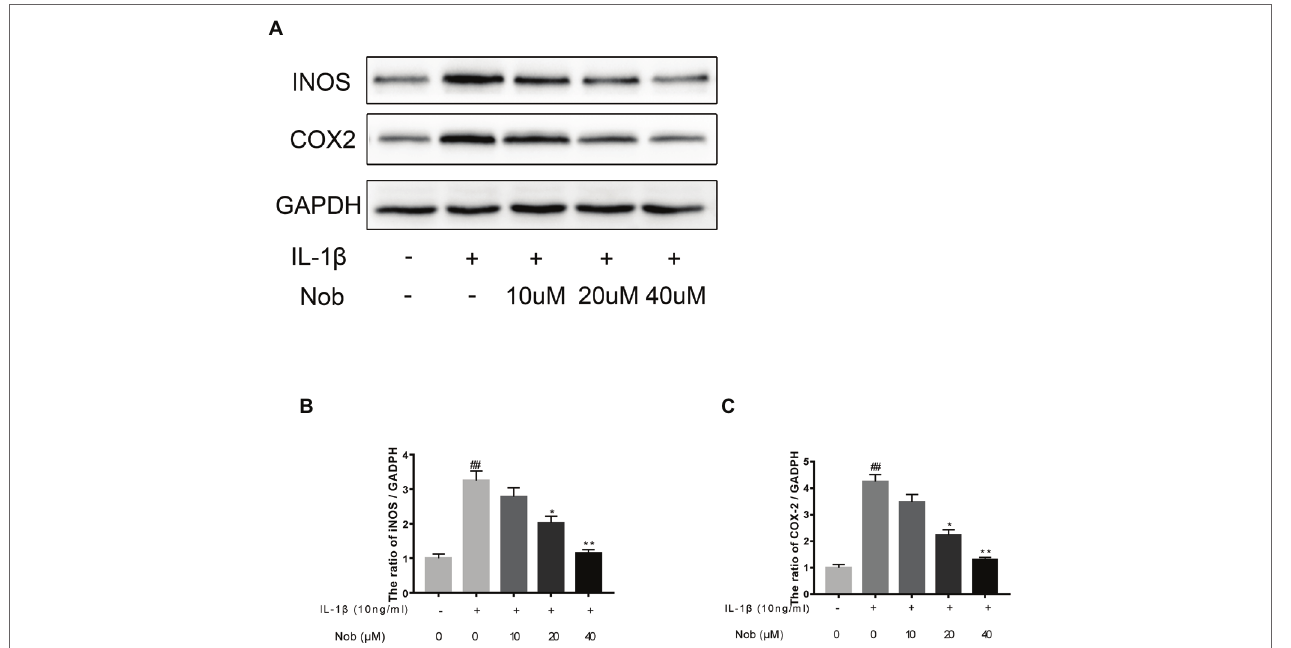
FIGURE 3 | Effects of nobiletin on INOS and COX-2 expression in chondrocytes. Cells were pretreated with various concentrations of nobiletin (0, 10, 20, or 40 μM, 24 h) before stimulation with IL-1 β (10 ng/ml, 24 h). Expression of INOS and COX-2 was assessed by Western blot analysis (A–C) . Values represent mean ± SD of three independent experiments. Significant differences are indicated as * p < 0.05, compared with control group. * p < 0.05 and ** p < 0.01, compared with IL-1 β group. ## p < 0.01, compared to the control group.